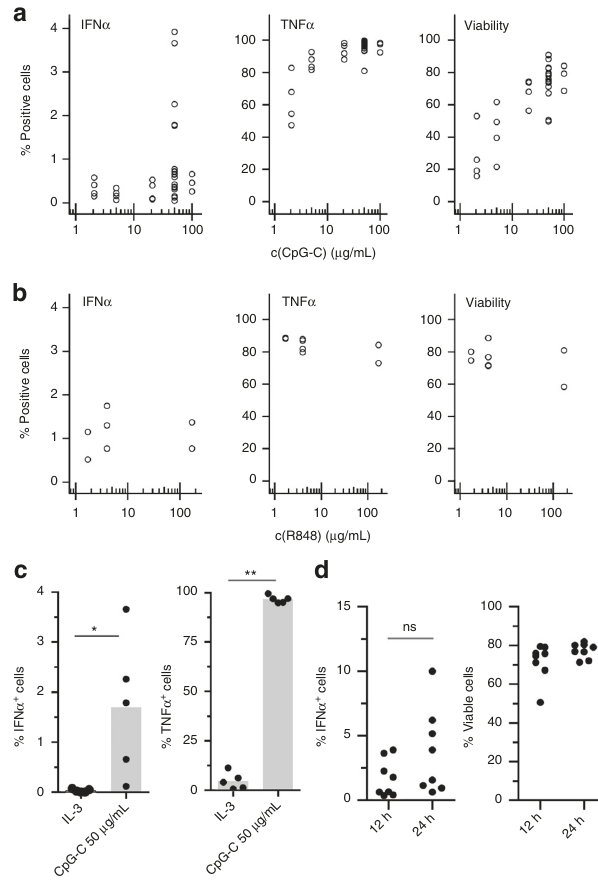
Fig. 2 TLR-L concentration does not in fl uence the fraction of IFN α - producing pDCs in droplets. a , b The pDCs were coated with capture reagent, encapsulated in picoliter droplets, and stimulated individually with a CpG-C or b R848 for 12 h. After staining for viability, surface marker expression and cytokine secretion, cytokine-secreting cells, and viable cells were detected via fl ow cytometry. Shown is the fraction of marker- expressing cells plotted against TLR ligand concentration. Different concentrations were tested in different donors; a n ≥ 3, b n ≥ 2. c The pDCs were treated as described above and stimulated with 0.01 µ g/mL IL- 3 or 50 µ g/mL CpG-C. Shown is the fraction of cytokine-secreting cells plotted against treatment condition; n = 5. Bars indicate mean. d The pDCs were treated as described above and stimulated with 50 µ g/mL CpG-C for 12 h or 24 h. Shown is the fraction of IFN α -secreting or viable cells plotted against treatment condition; n = 8 ( c , d ) Mann – Whitney test * p < 0.05, ** p <